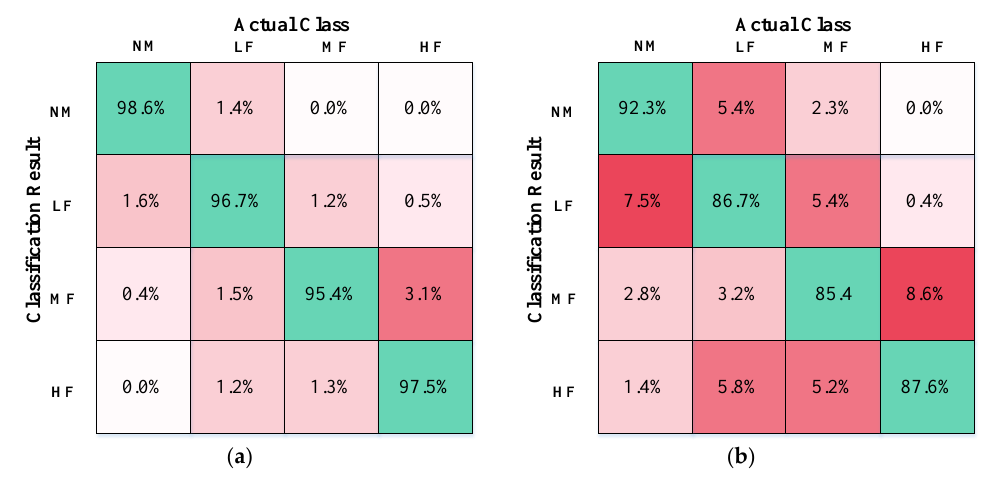
Figure 5. The comparison results for the feature selection using the support vector machine (SVM) classification (20% training data). ( a ) confusion matrix with feature selection in Fisher score; ( b ) confusion matrix without feature selection.